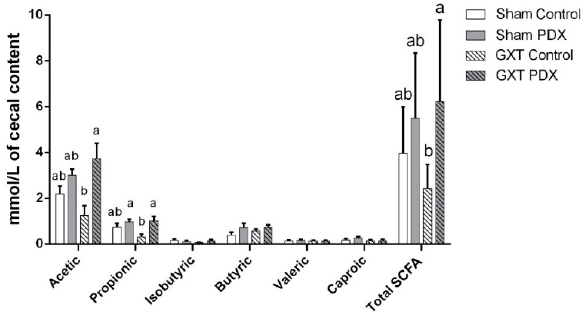
Figure 4. Concentration of SCFA (mmol/L) (acetic acid, propionic acid, isobutyl acid, butyric acid, valeric acid, caproic acid and total SCFA) of animals in the experimental group. Bars with same letters indicate no significant difference according to Tukey’s test ( p < 0.05). Different letters indicate a significant difference to the Tukey test ( p < 0.05). Sham Control: sham without polydextrose; Sham PDX: sham with polydextrose (7.5%); GXT Control: gastrectomized without polydextrose; GXT PDX: gastrectomized with polydextrose (7.5%). Values expressed as mean ± SEM.